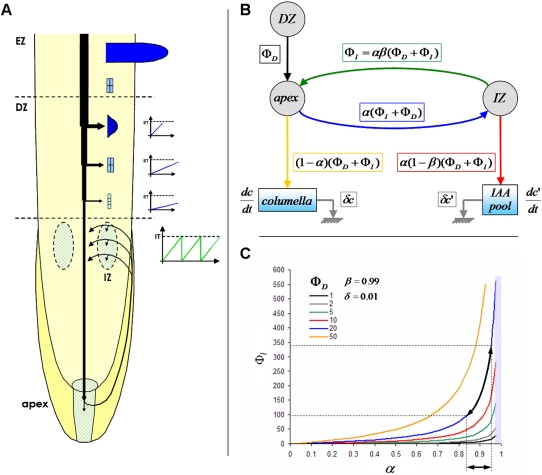
Mechanistic model of lateral root initiation and development.(A) Structure of the model. Auxin reflux takes place though the initiation zone (IZ). A fraction of the reflux accumulates until the initiation threshold (IT) is reached. A new primordium then appears and depletes auxin in the IZ. Primordia going through the development zone (DZ) drain a percentage of the central auxin flux. Primordia will emerge if their auxin content is higher than the emergence threshold (ET). Emerged laterals cease consuming auxin. Primordia which have not yet emerged when they leave the DZ for the emergence zone (EZ) will stop developing. Gravistimulation is considered to induce a drop of IT and to consume a fraction of the auxin in the IZ. IT and ET both vary dynamically according to Gaussian distributions. Auxin production augments after one week. (B) Mathematical representation of the reflux system. Fluxes coming from the development and initiation zone are denoted as ΦD and ΦI. The reflux efficiencies are denoted α and β, while δ expresses auxin degradation in the meristem and in the IZ. (C) Auxin fluxes passing through the IZ at equilibrium. As the reflux is considered to be imperfect, the flux going through the IZ will reach a stable point depending on the efficiencies of the refluxes α and β and on the central flux entering the IZ from the DZ (value in arbitrary units of production per minute). For high values of reflux efficiency, a small variation in reflux efficiency or entering fluxes will lead to a strong change of stable point (black arrows).